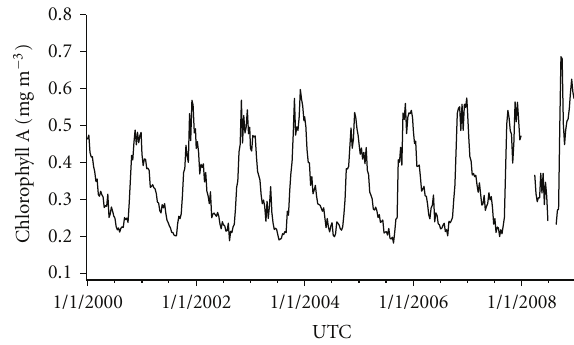
Figure 2: Time series of 8-day averaged Sea-WiFS chlorophyll A concentration in Southern Ocean region (42 ◦ S–60 ◦ S, 180 ◦ W – 180 ◦